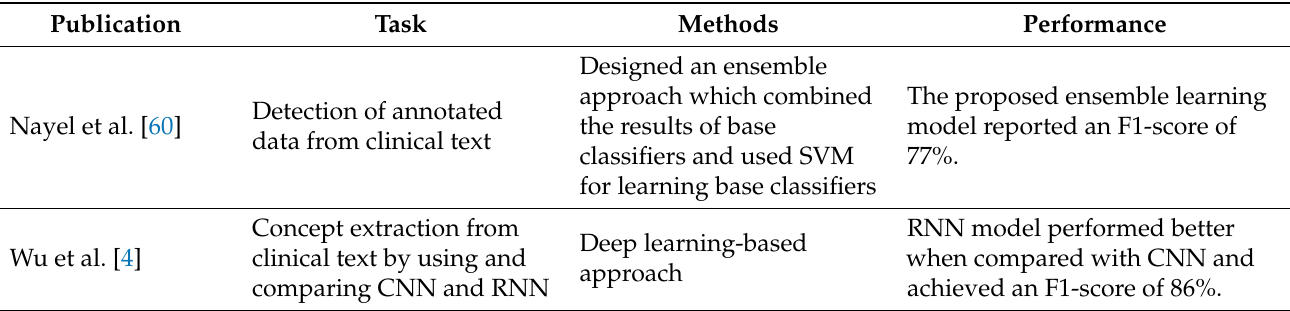
Table A2. Summary of previous work for clinical